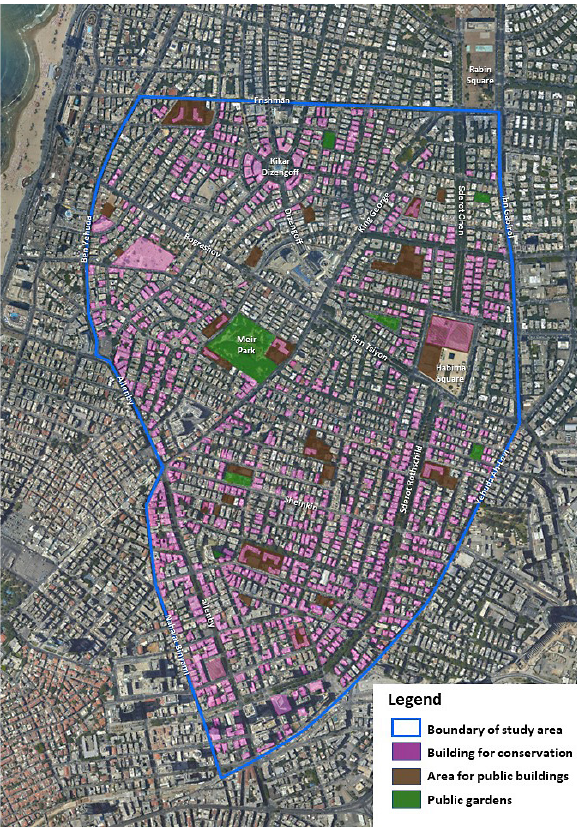
Figure 1. Map of the White City of Tel Aviv (heritage district)